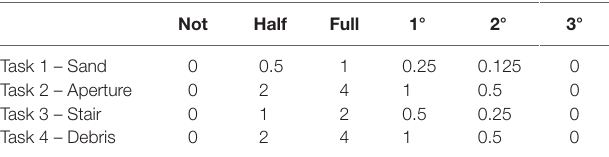
tABLe 2 | scoring of the terrestrial